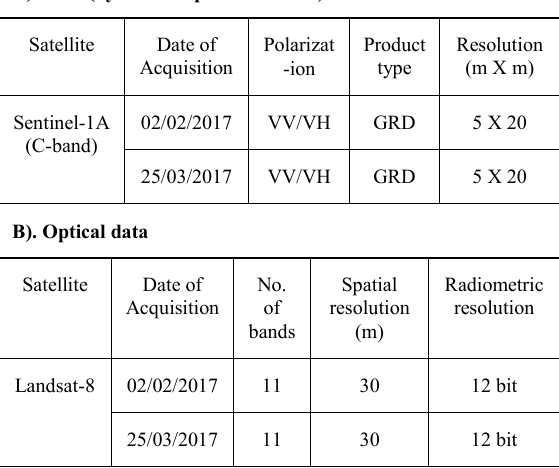
Table 1.SAR and Optical satellite data